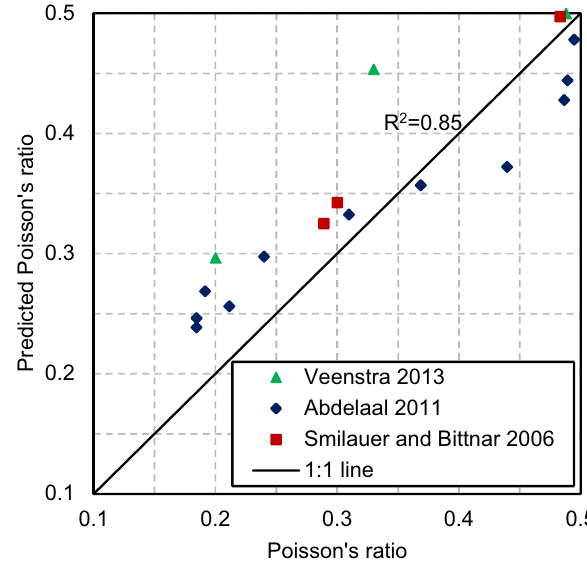
Fig. 4 Experimental versus predicted values of elastic modulus.